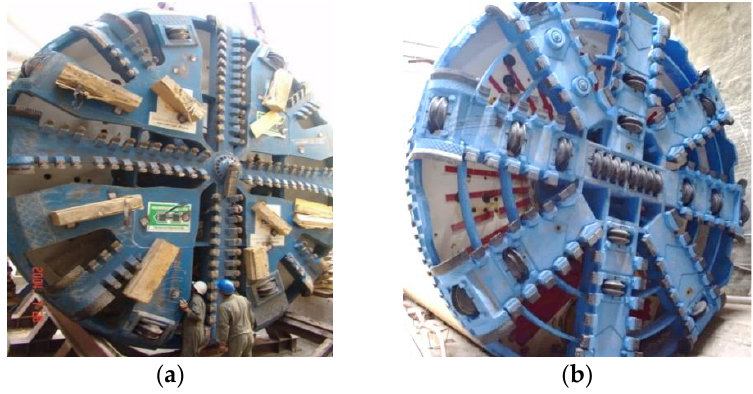
Figure 10. Cutterhead of EPBM in ( a ) Line 1 and ( b ) Line 2.